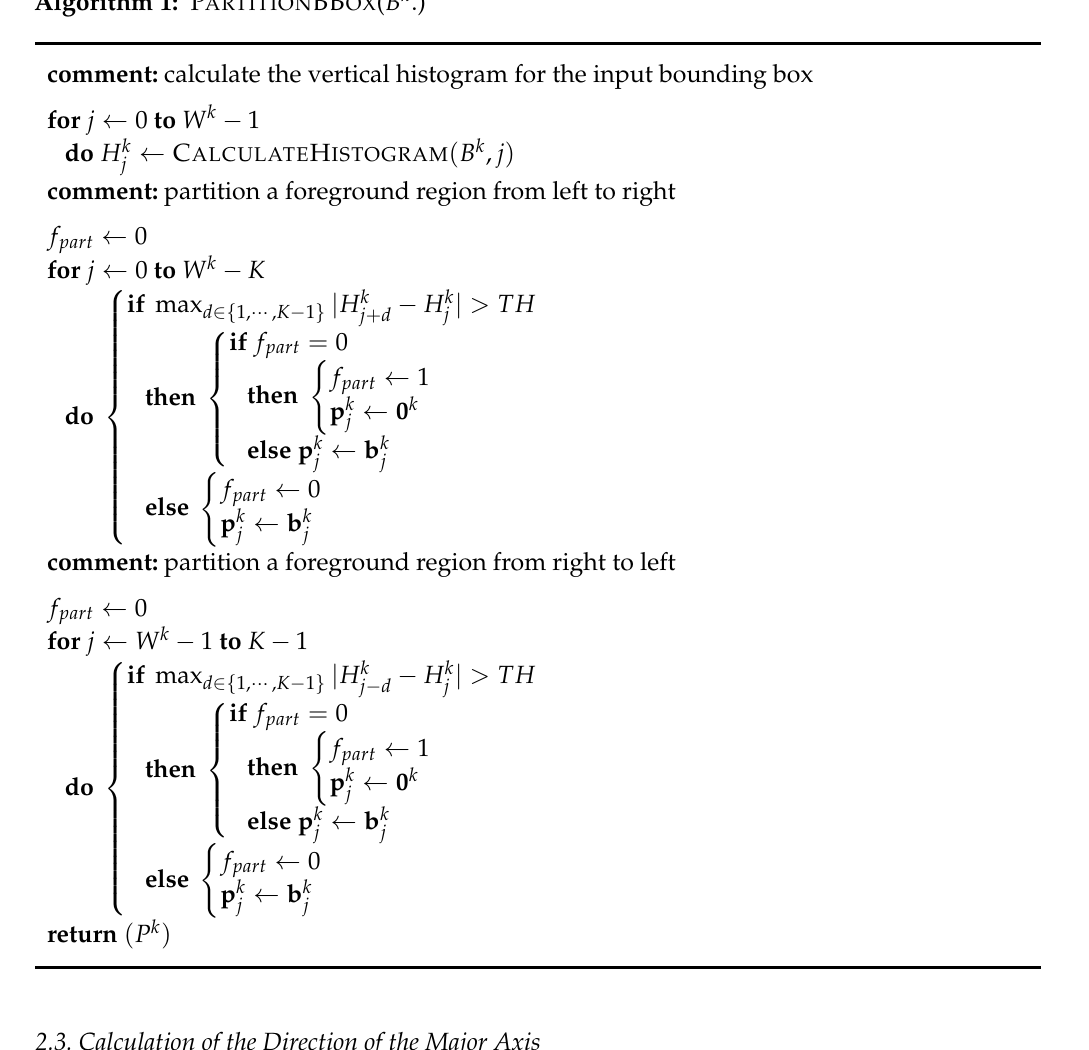
Algorithm 1: P ARTITION BB OX ( B k